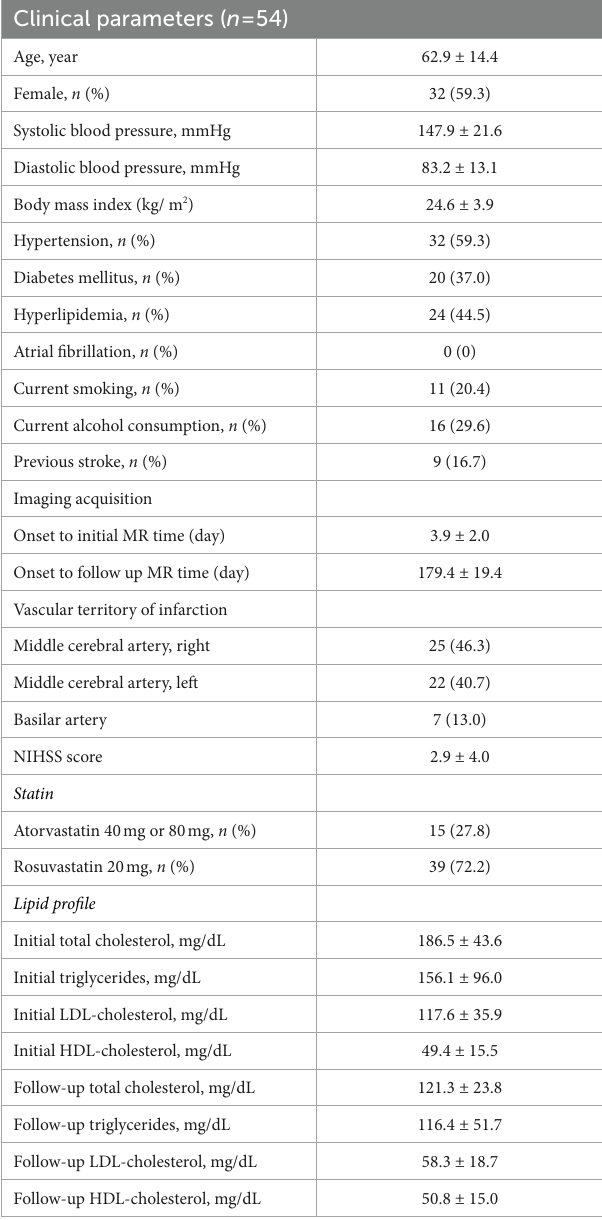
TABLE 1 Baseline characteristics, vascular risk factors, and laboratory findings of the study patients.